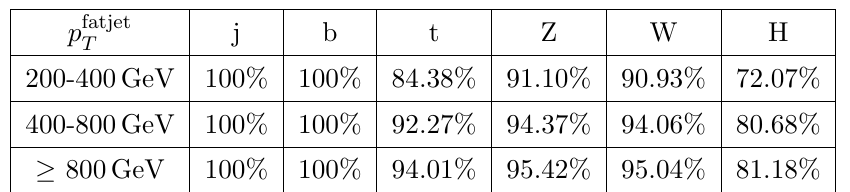
Table 8 . Jet-(cid:12)nding e(cid:14)ciencies as a function of jet p T in the 6 SM samples used for training and validating the CNN